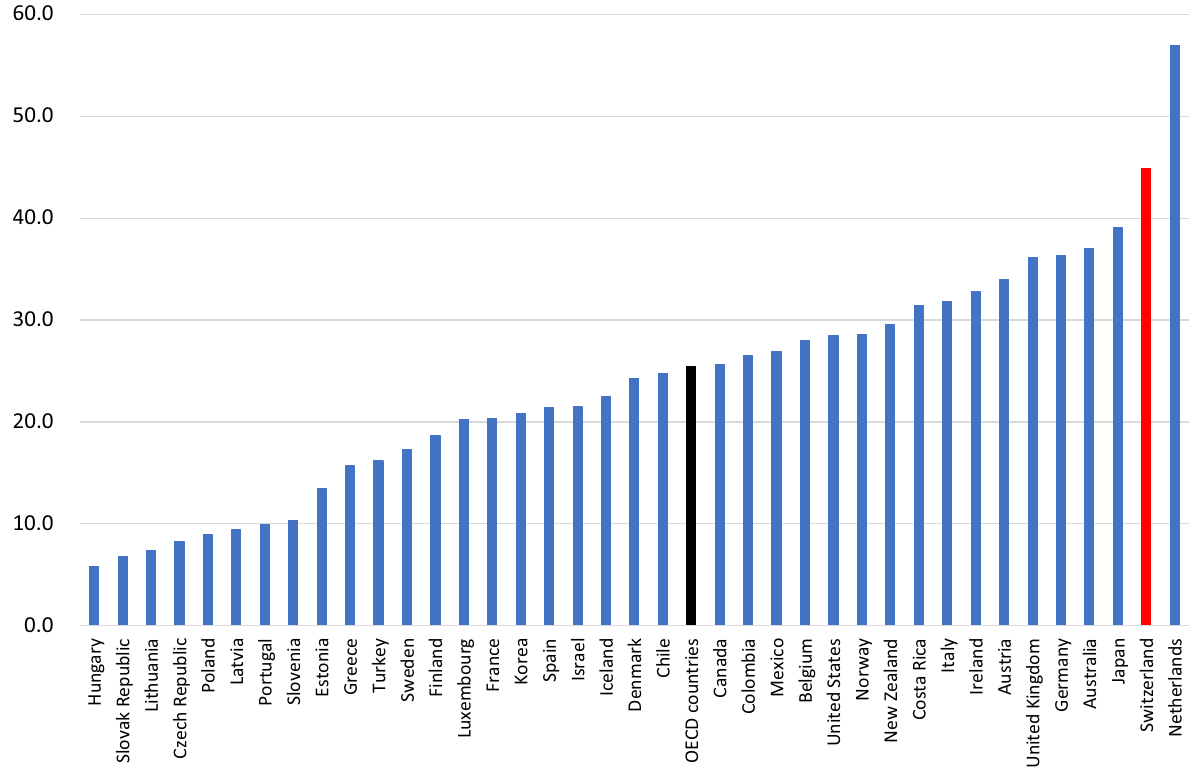
Fig. 4 Women employed in part-time work, as percent of total employed women (2019). Notes Data (for all countries except the USA) from the OECD labor force statistics; data for the USA come from the Current Population Survey. The part-time rate is calculated as the number of employed women working less than 30 hours (35 for the USA) weekly over the total number of employed women.